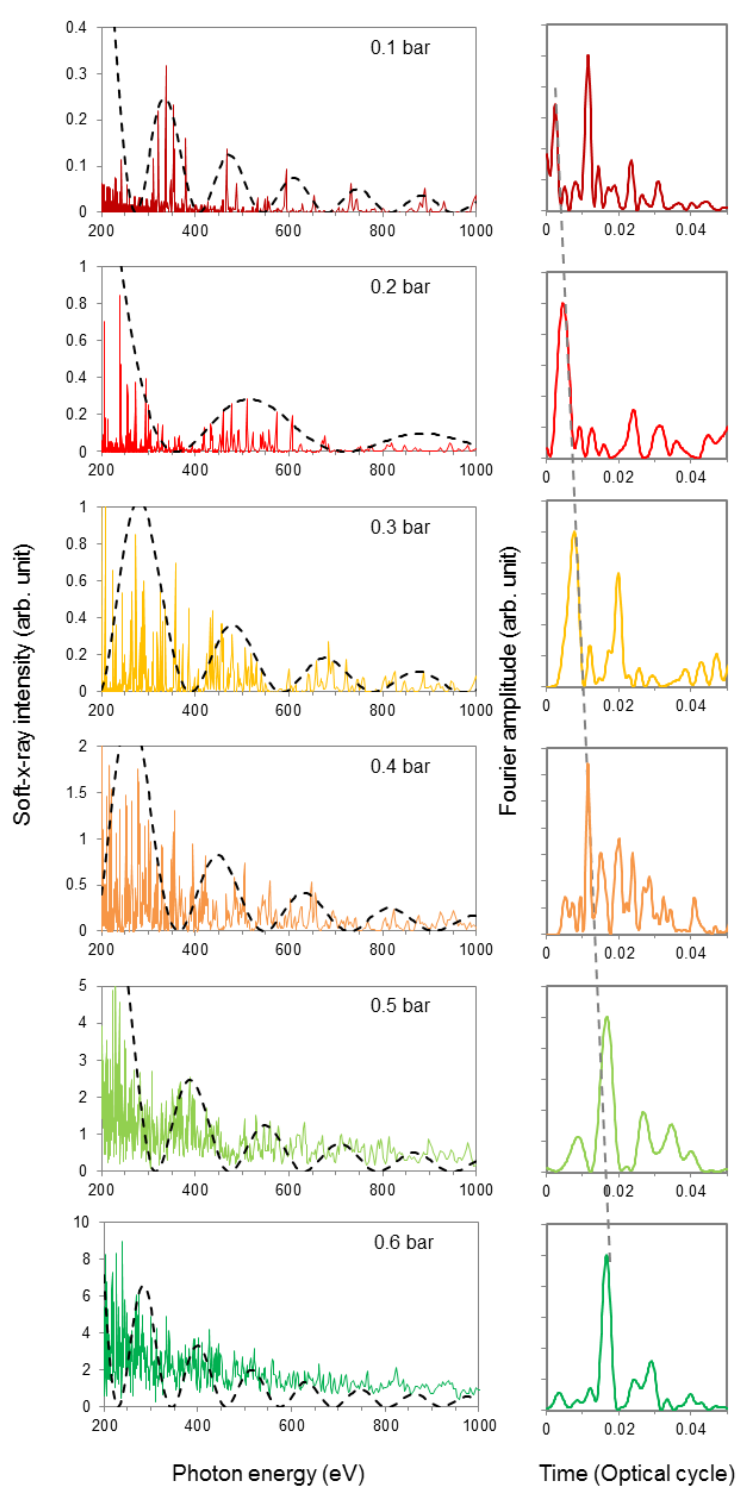
Figure 2. ( Left ) The high harmonics generation (HHG) spectra in the range of 0.2–1 keV have been recorded for different He backing pressures. The dashed curves are the fitted spectral envelopes calculated from Equation (6). ( Right ) Fourier transform of the recorded spectrum. The grey dashed line shows the linear shift of the first peak of the Fourier-transformed signal with gas